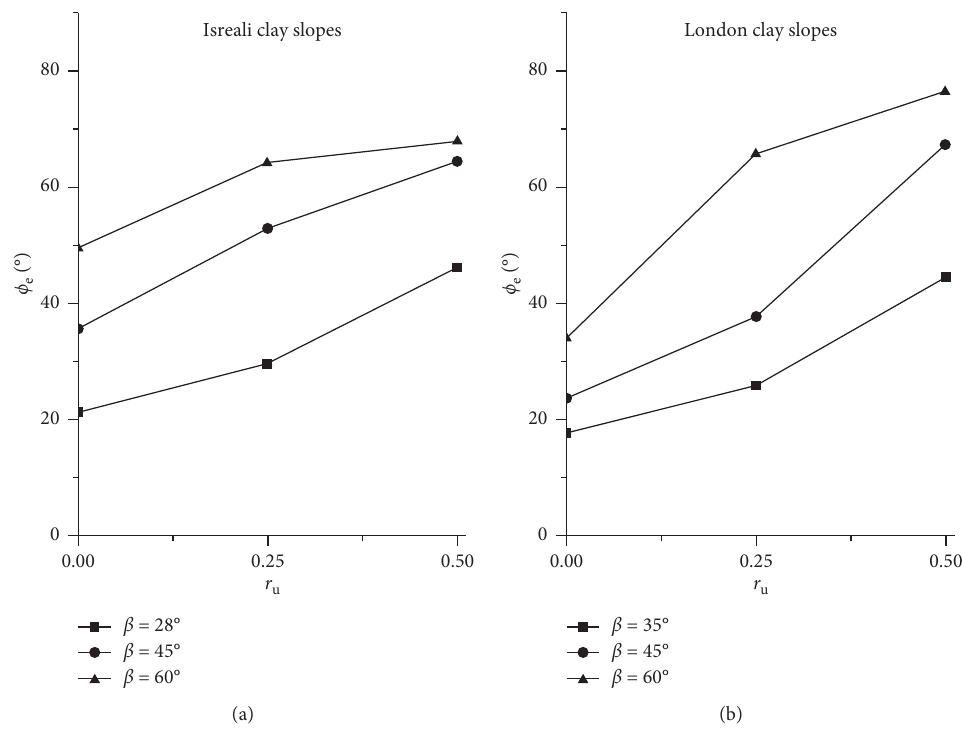
Figure 13: Effect of r u on equivalent friction angle ϕ e . (a) Israeli clay slope. (b) London clay